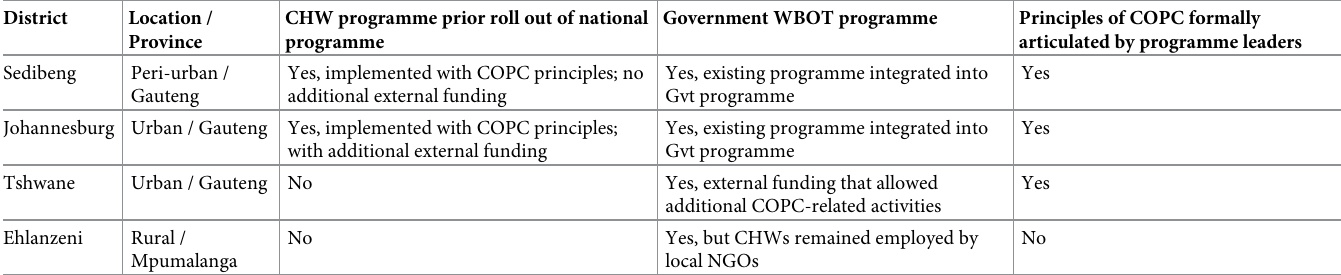
Table 2. Description of site, CHW programme and COPC practices.